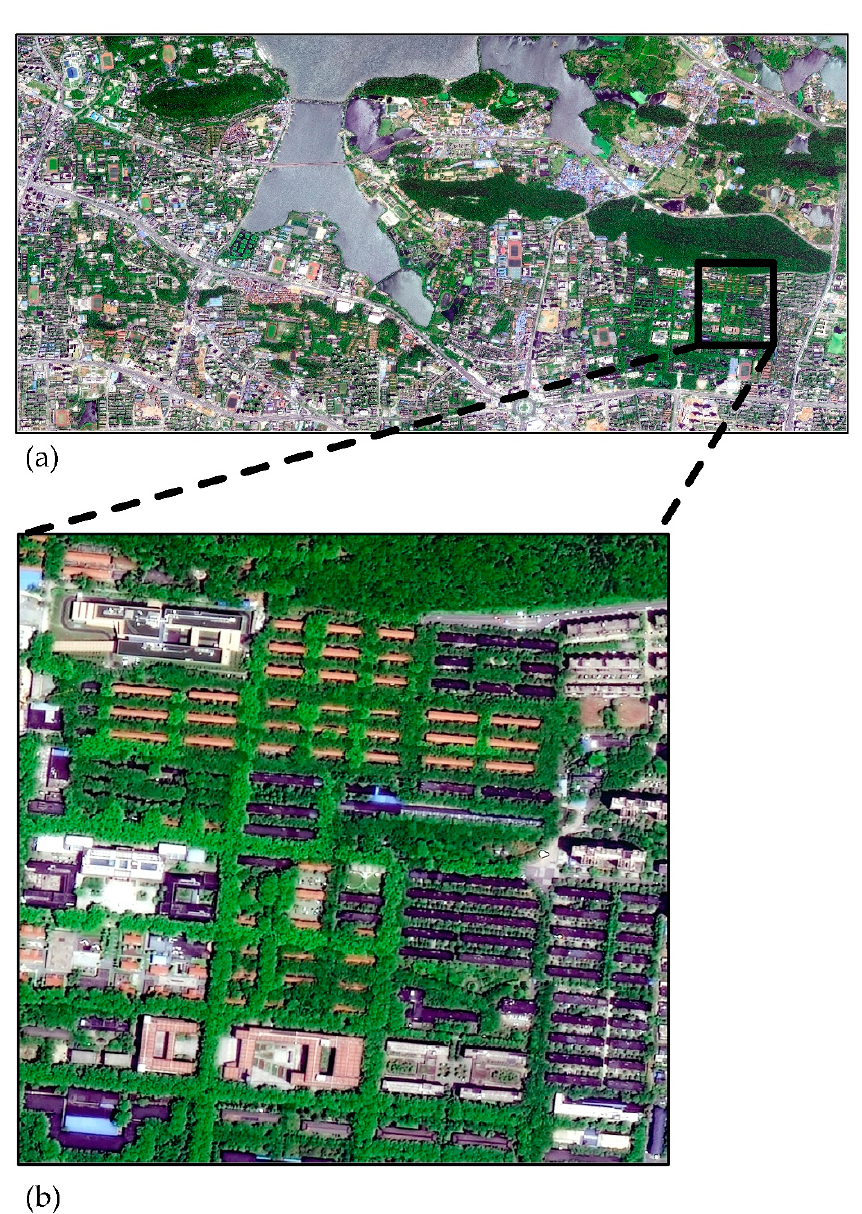
Figure 11. The study area from the GF-2 image: ( a ) the image of the whole study area; ( b ) the subimage selected from the study